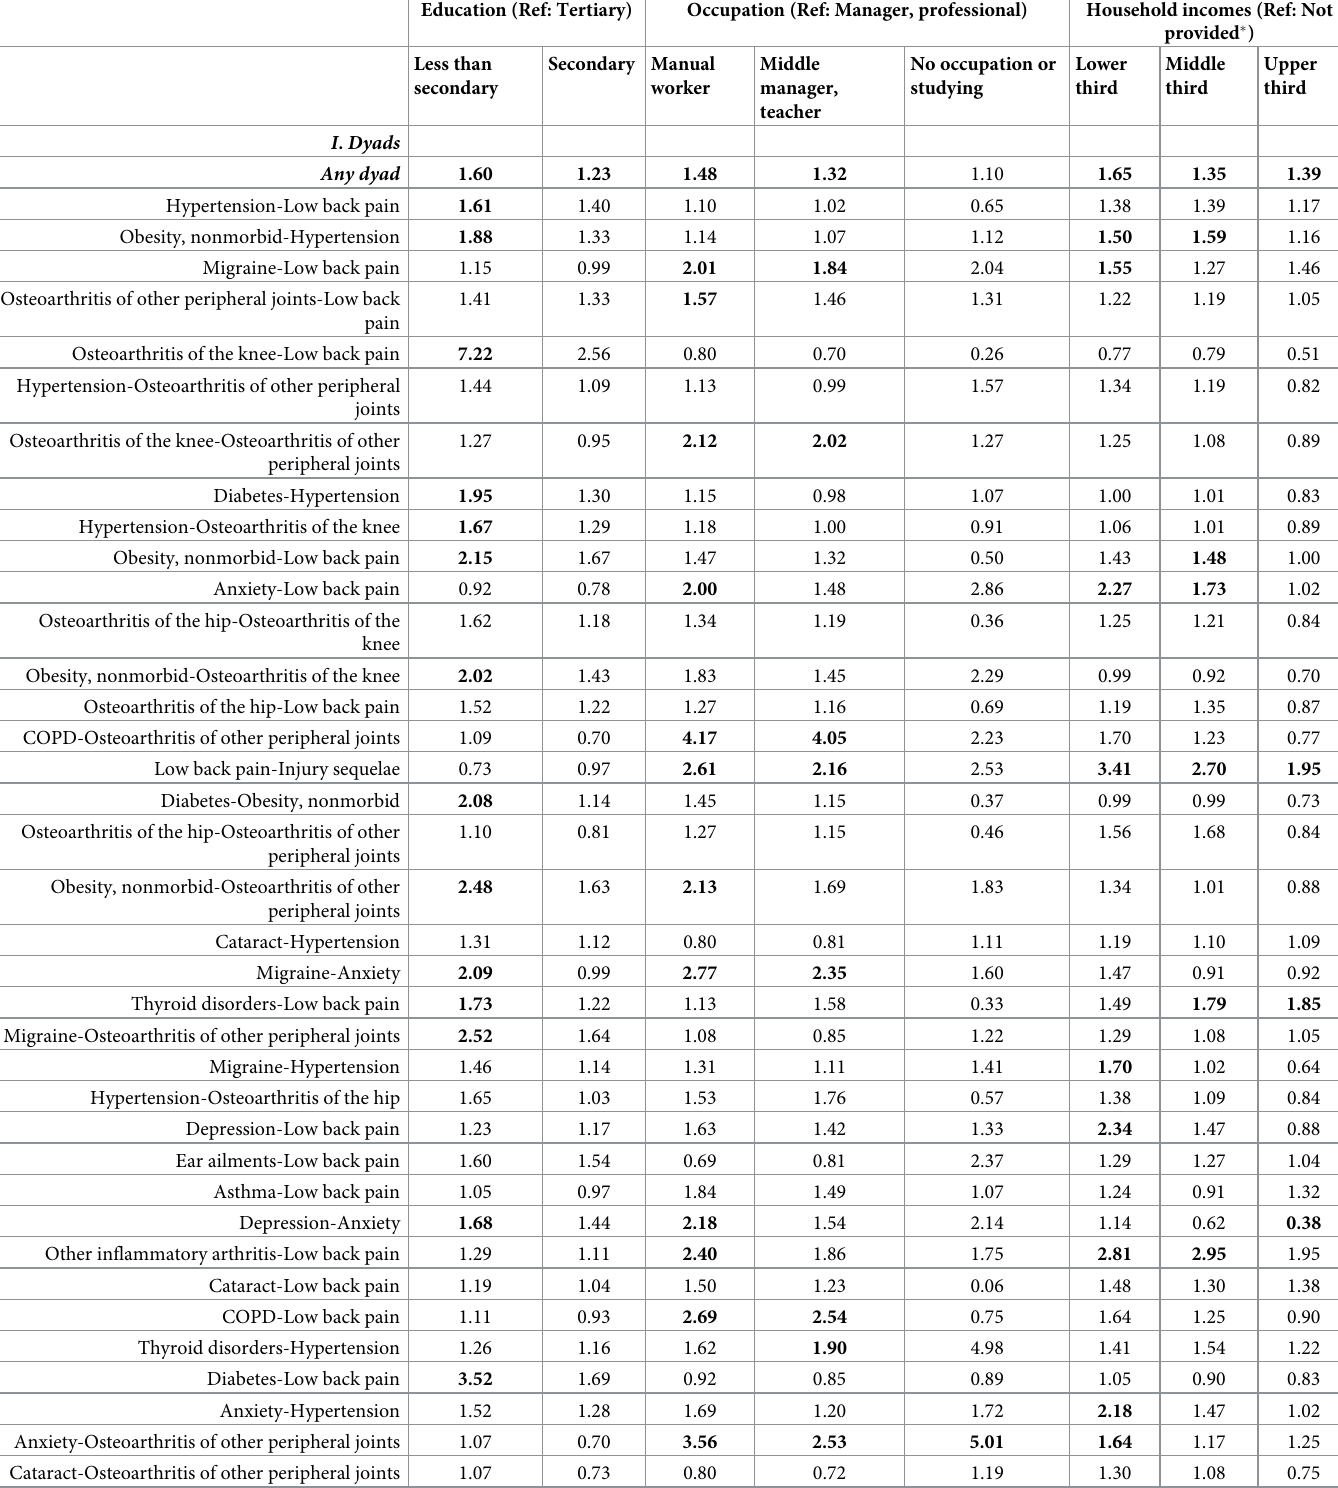
Table 5. Risk of a given dyad or triad associated with the three socioeconomic status indicators (education level, occupation, and household income) as estimated in multiple binary logistic regression models including age, gender, and all three sociodemographic variables.